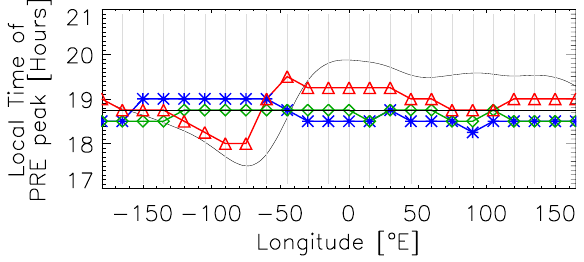
Fig. 6. Local time variation of the occurrence of the PRE plasma drift velocity peak ( v P z ) for December Solstice (blue), equinox (green) and June solstice (red) versus longitude. The black curve indicates the latitudinal variation of the dip equator. The black hor- izontal line represents the geographic